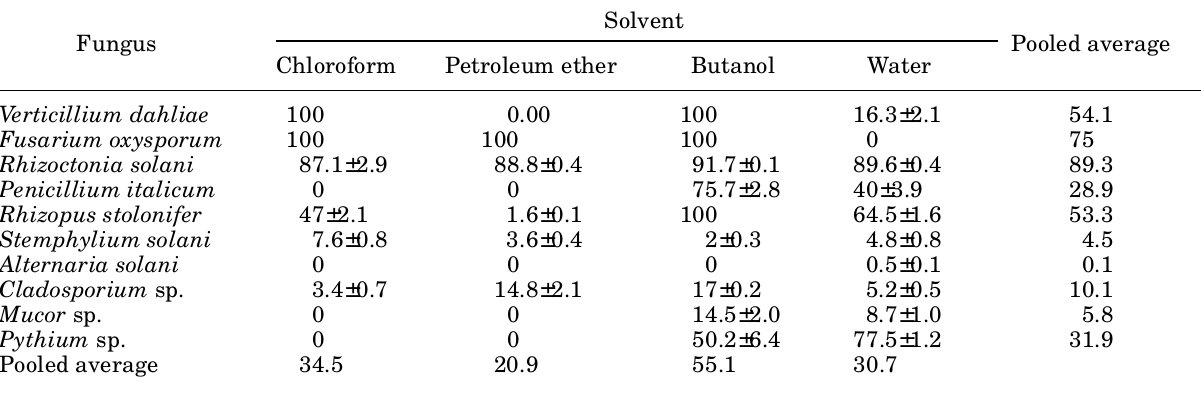
Table 3. Inhibition (%) a of fungal growth with extracts from flowers of Euphorbia macroclada .